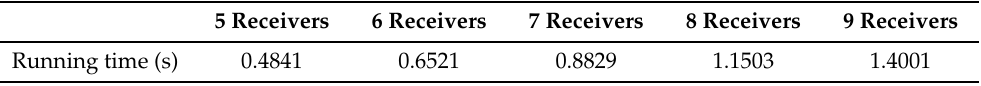
Table 3. Running time of the proposed method under a different number of receivers. 5 Receivers 6 Receivers 7 Receivers 8 Receivers 9 Receivers Running time (s) 0.4841 0.6521 1.1503 1.4001